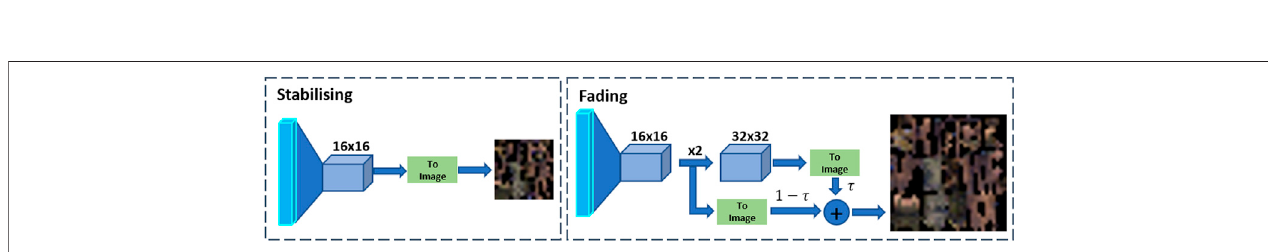
FIGURE 4 | Progressive appearance training overview. Convolutional layers training stages, Stabilising stage with 16 × 16 resolution, and Fading stage to the next 32 × 32 resolution layer.